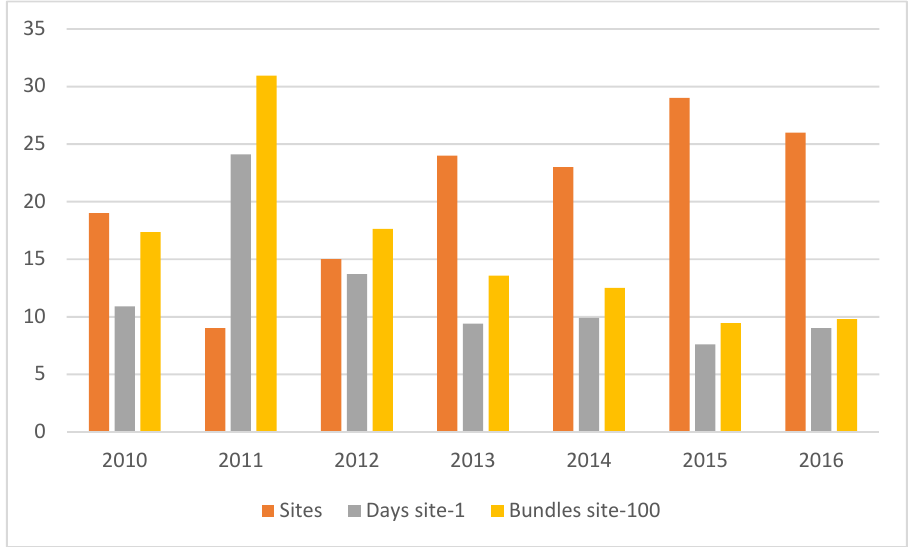
Figure 5. Main worksite statistics from 2010 to 2016.